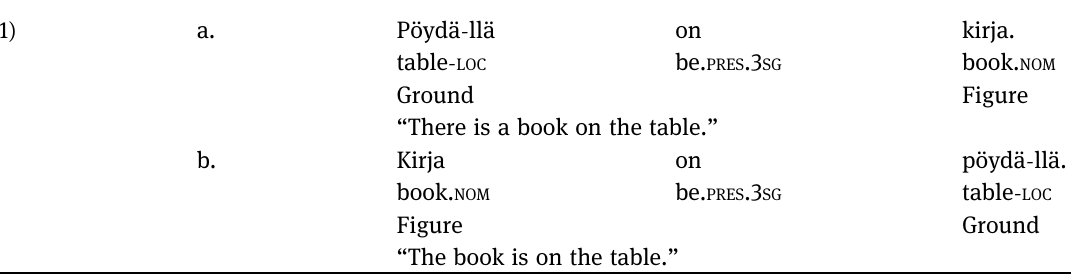
“ The book is on the table.